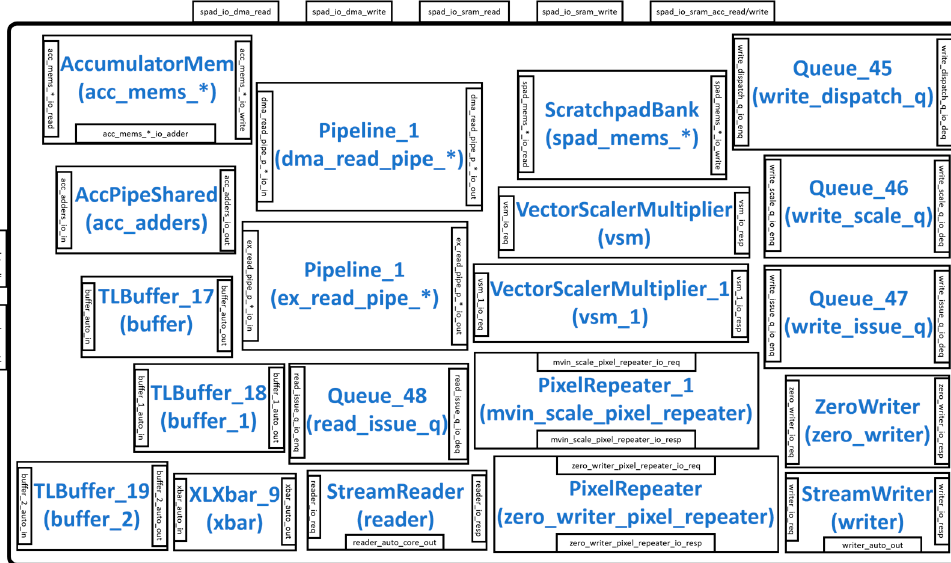
Figure 9. Scratchpad module.